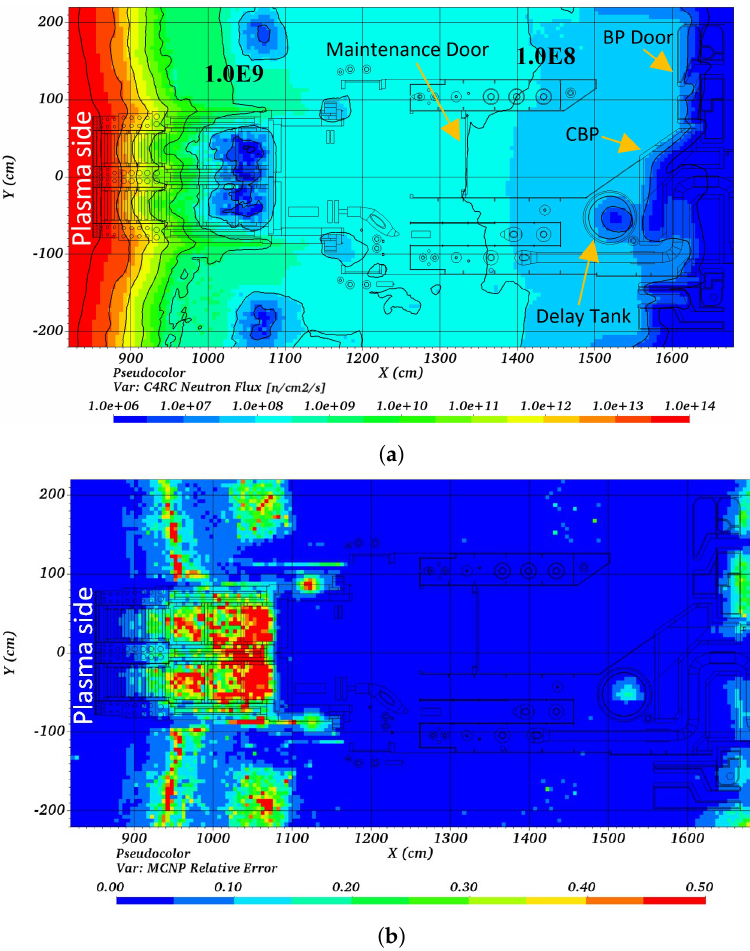
Figure 6. ( a ) C4RC Total Neutron Flux [n/cm 2 /s] and ( b ) MCNP Relative Error in